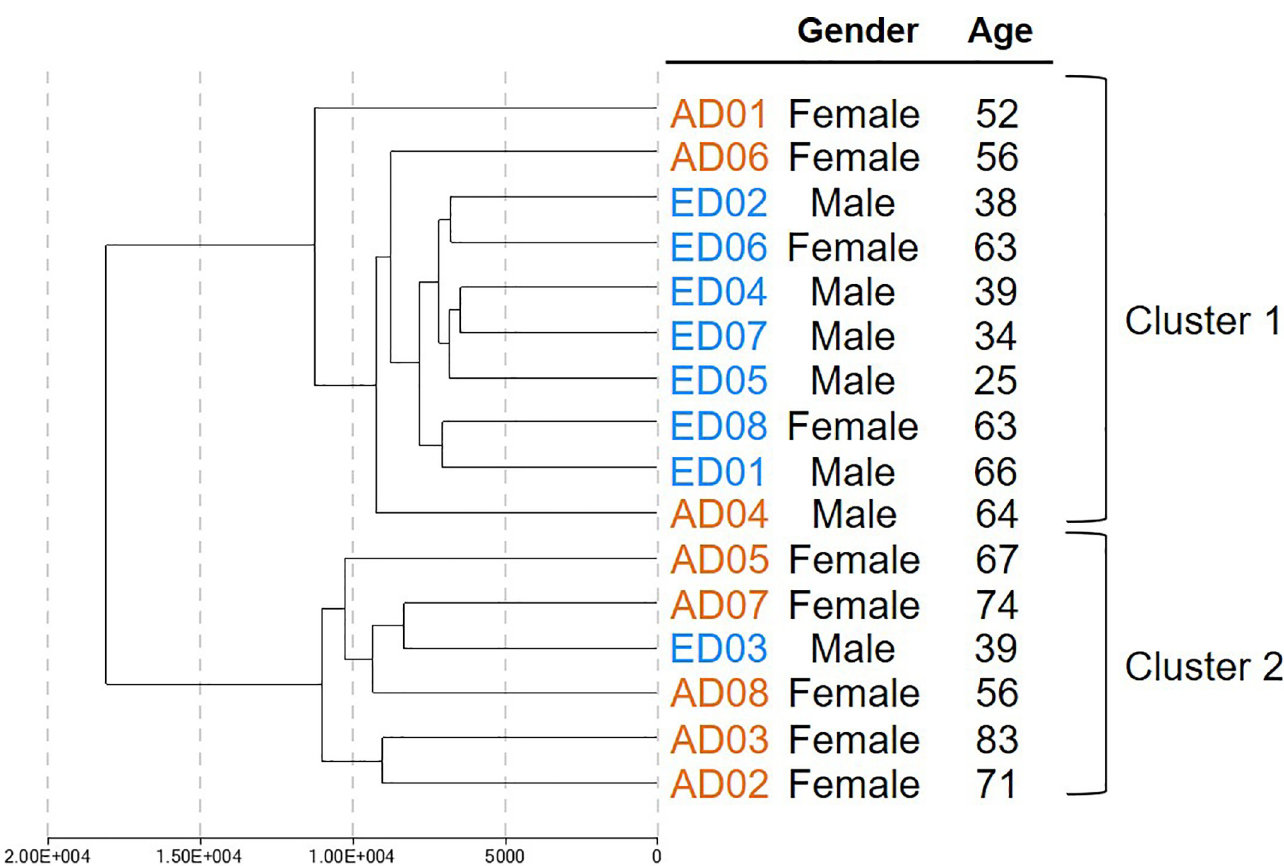
Fig 2. Unsupervised hierarchical clustering of DNA methylation values of human nucleus pulposus (NP) tissues in eight early stage (ED) and eight advanced stage (AD) of disc degeneration.